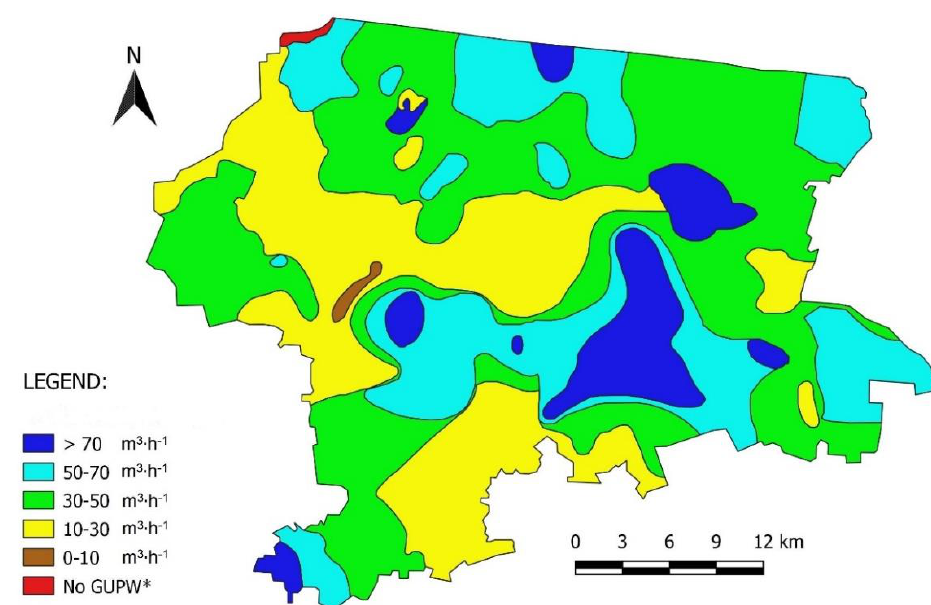
Figure 3. Areas with the potential capacity of a drilled well of main utility level in Braniewo poviat (own study based on [58]). * GUPW—the main usable groundwater level. Table 3. Characteristics of groundwater resources in Braniewo poviat based on the analysis of the potential capacity of a drilled well containing the main usable groundwater